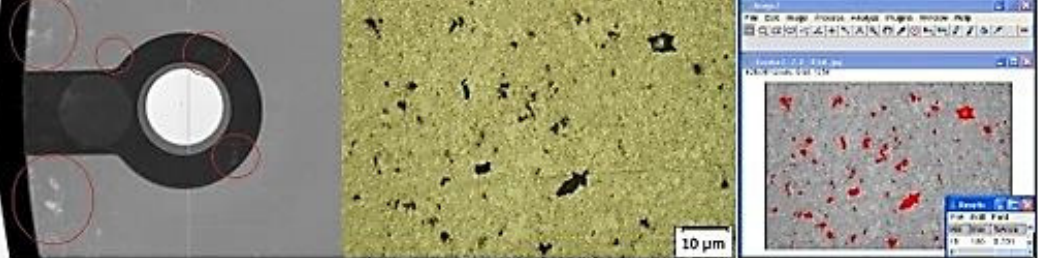
Figure 3. Analysis of specimen A.1.